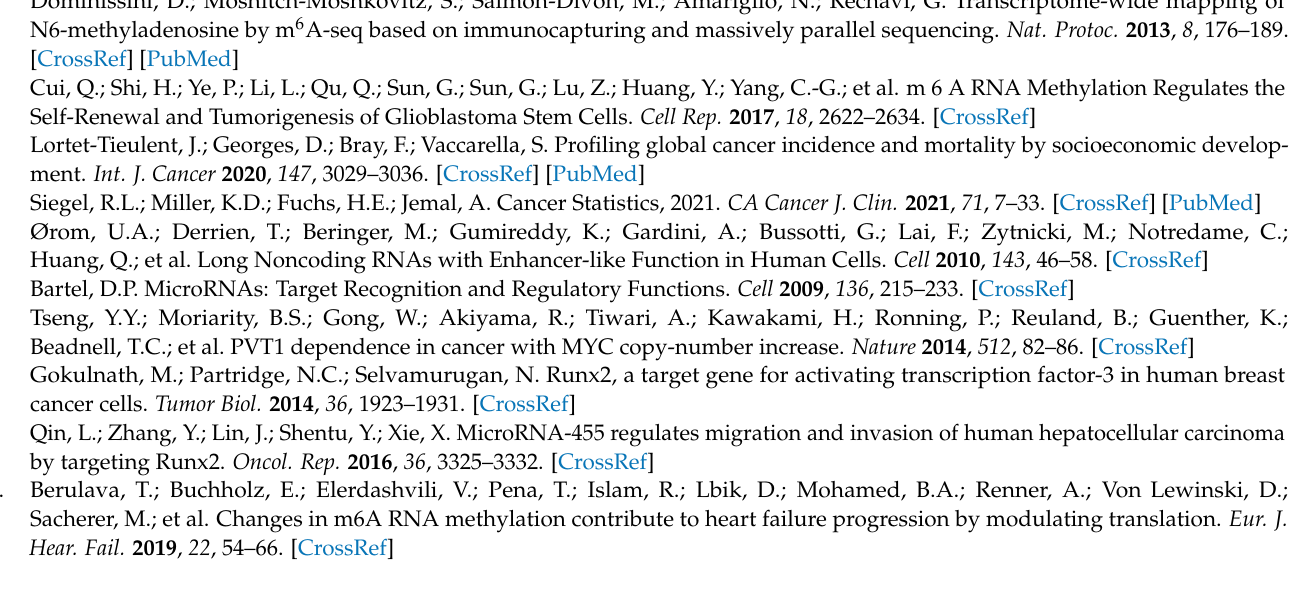
Figure S4: Additional correlation analysis; Table S1: Sequences of all the shRNAs; Table S2: Primer sequences for